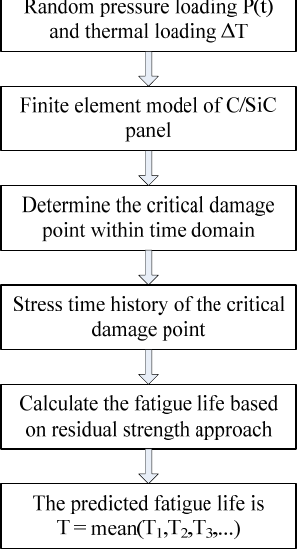
Figure 1. Procedure of the algorithm of fatigue life assessment.